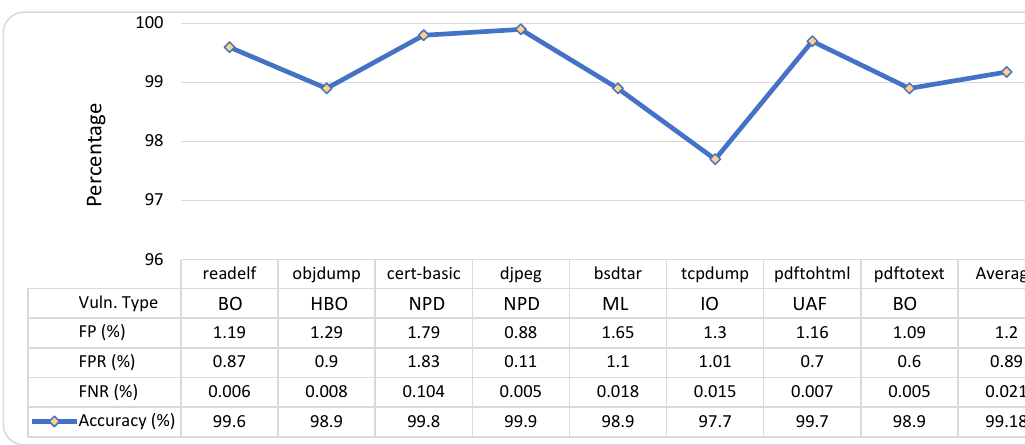
Figure 6. Accuracy results on eight real-world